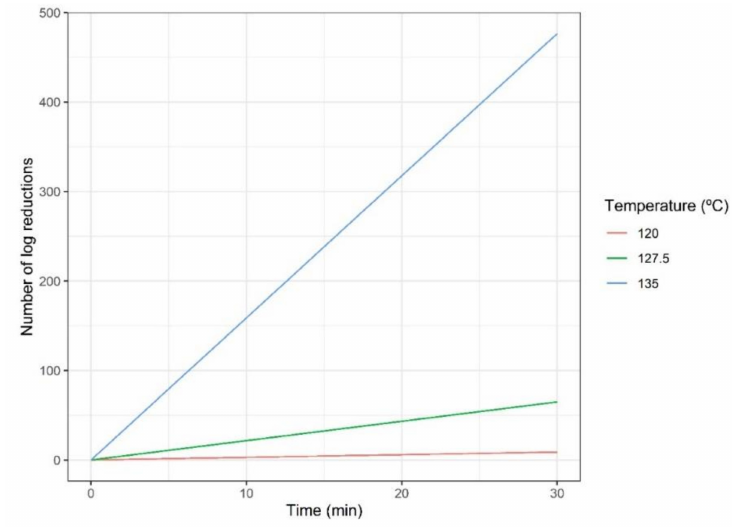
Figure 3. Geobacillus stearothermophilus inactivation dynamics according to the Bigelow